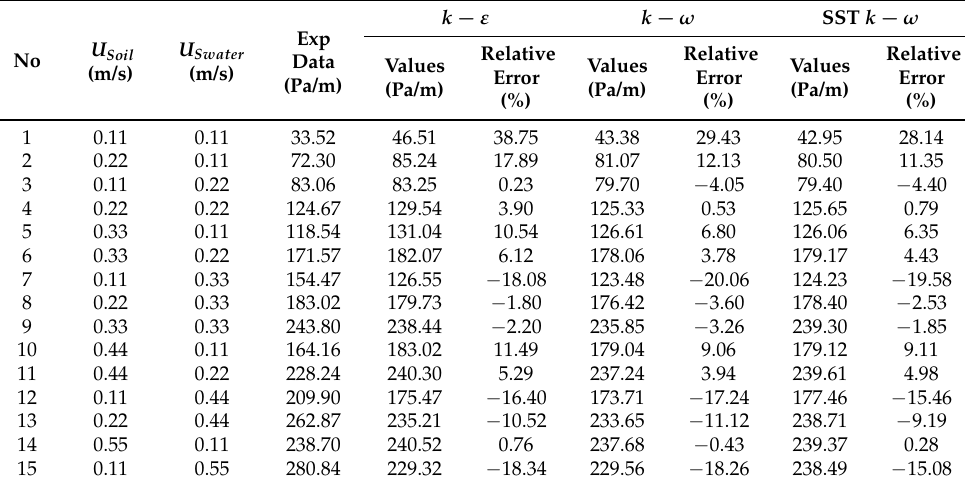
Figure 6. Comparison between calculation and experiment for pressure gradient under different turbulent models. Table 2. Comparison of pressure gradient between model predictions and experimental measure-